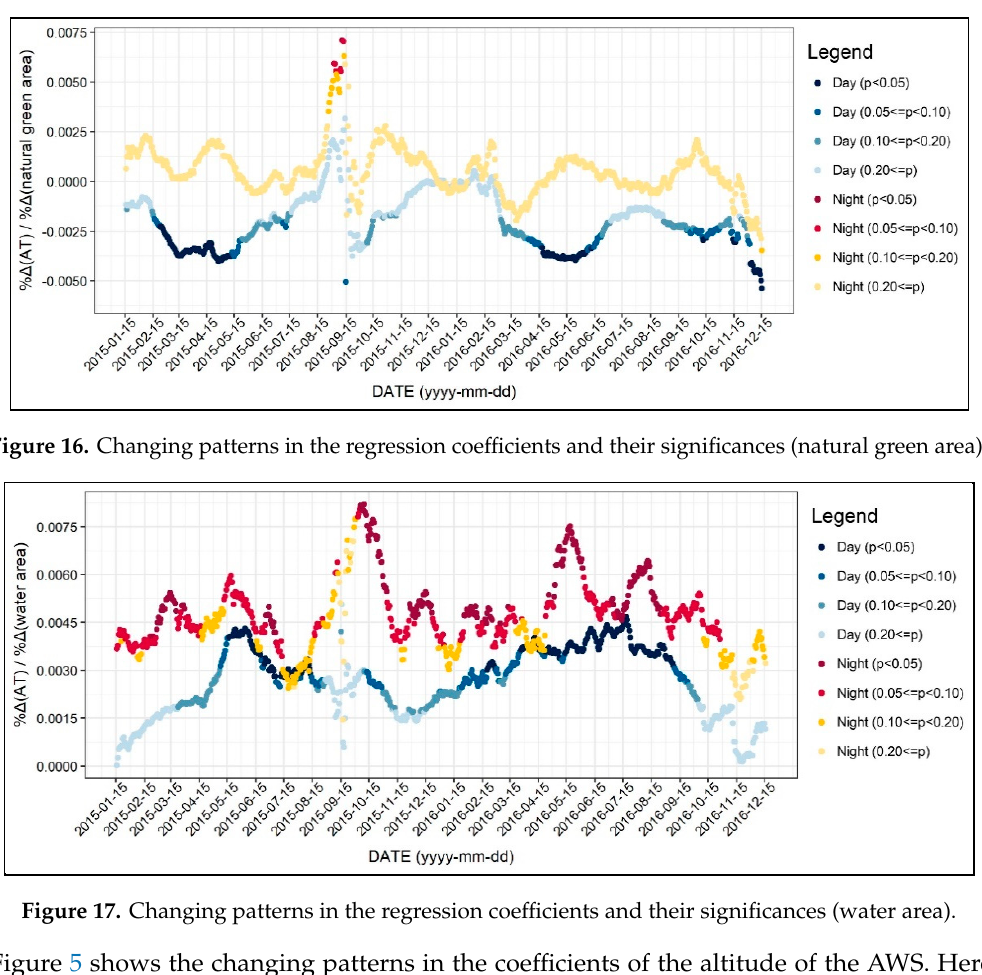
15 of 20 Figure 15. Changing patterns in the regression coefficients and their significances (artificial green area). Figure 16 shows the diurnal and seasonal variations in the effect of natural green area on air temperature. As indicated by the blue dots, larger natural green area was associated with lower daytime air temperature. However, the coefficients were significant only during spring and winter. For instance, during spring, a 10% increase in the natural green area would reduce the daytime air